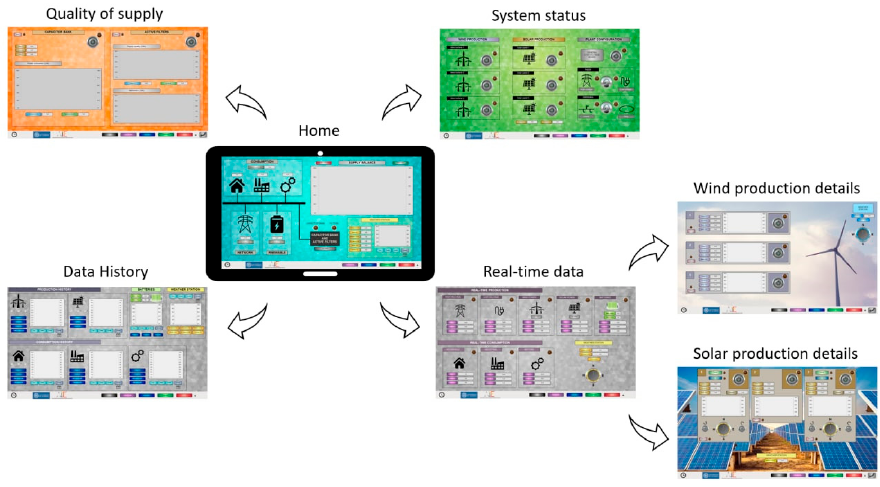
Figure 4. General view of the developed